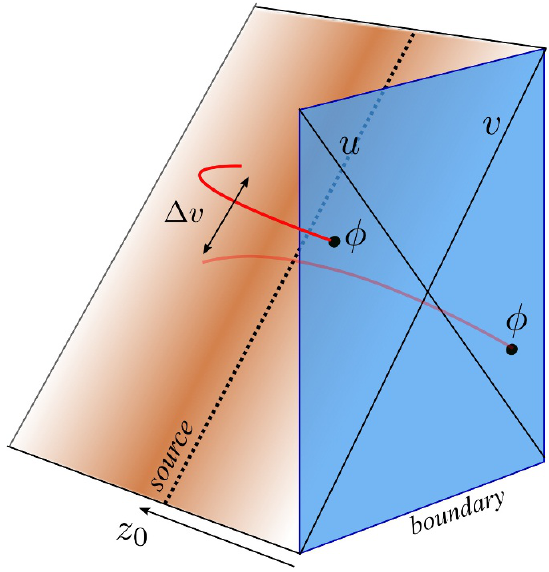
Figure 6 . Setup for the four-point function. The metric is a real shockwave, created by inserted at imaginary kinematics. (cid:30) is a probe, and h j (cid:30)(cid:30) j i is computed from the geodesic length. The geodesic jumps by (cid:1) v across the shockwave. The transverse directions ~x also play a role but are suppressed in the